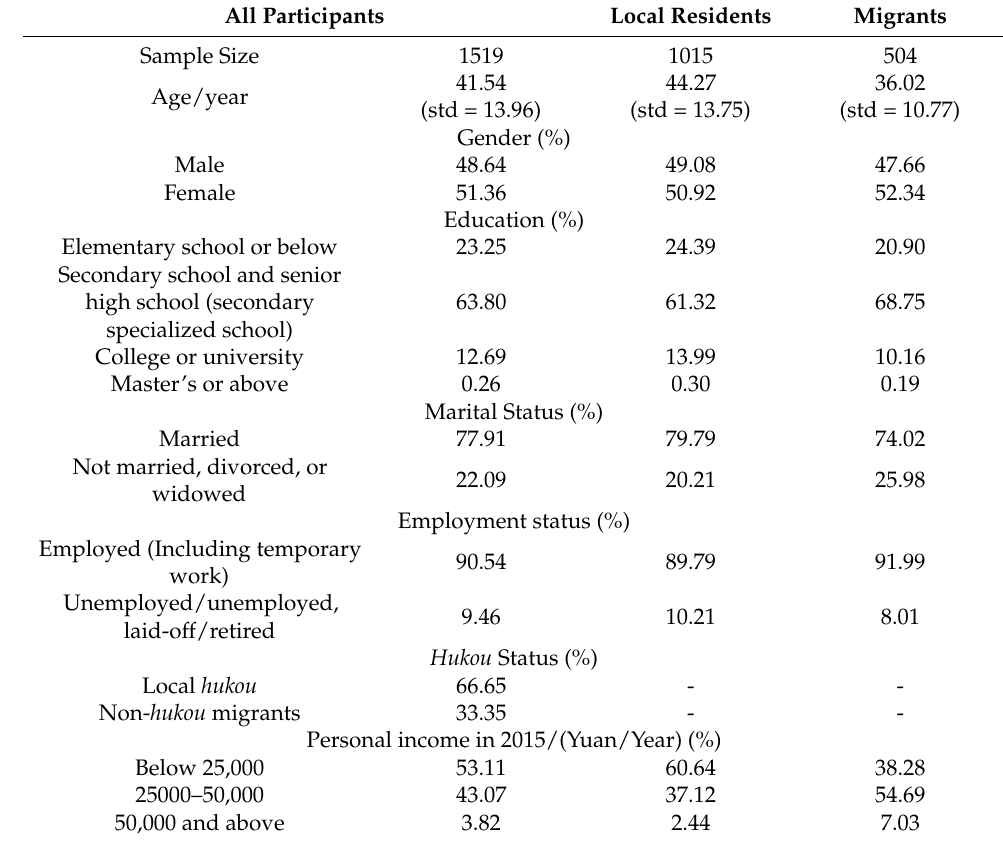
Table 1. Sociodemographic characteristics of the entire